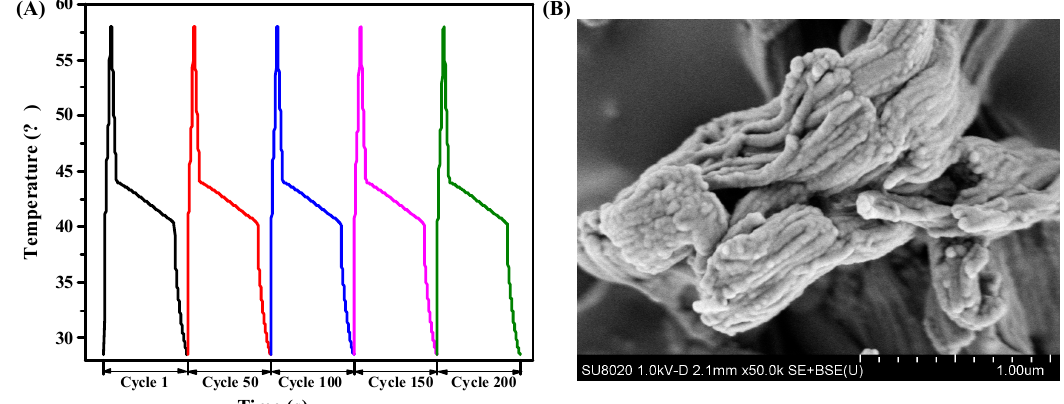
Figure 13. Photo-thermal performance of PCM at different cycles(A) and SEM image of PCM after 200 cycle.